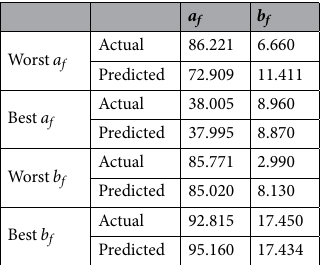
Table 3. Predicted and actual values of myocardial properties for the best and worst predictions of a f and b f in the testing dataset ( n = 100).